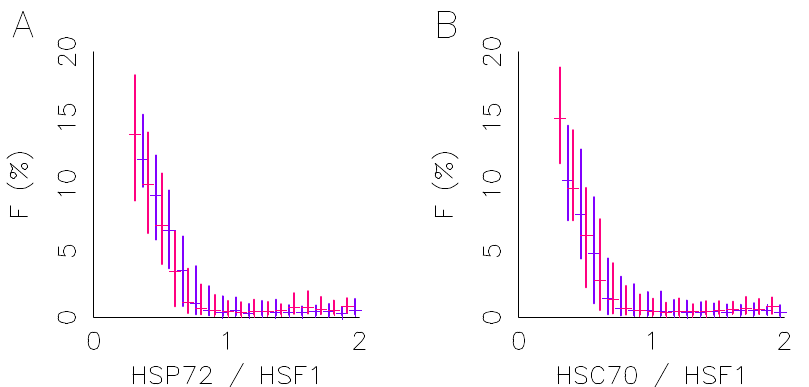
Figure 3. Foci intensity varies with protein concentration. This figure focuses on foci intensity after one hour at a 43 ◦ C temperature in HeLa-HSF1:eGFP cell lines obtained by immunofluorescence targeting HSP72 and HSC70, respectively. Foci intensity distribution (box plot) vs. HSP72 to HSF1 ratio ( A ), or HSC70 to HSF1 ratio ( B ). (Blue) cells adhered to non-coated, (red) cells adhered to